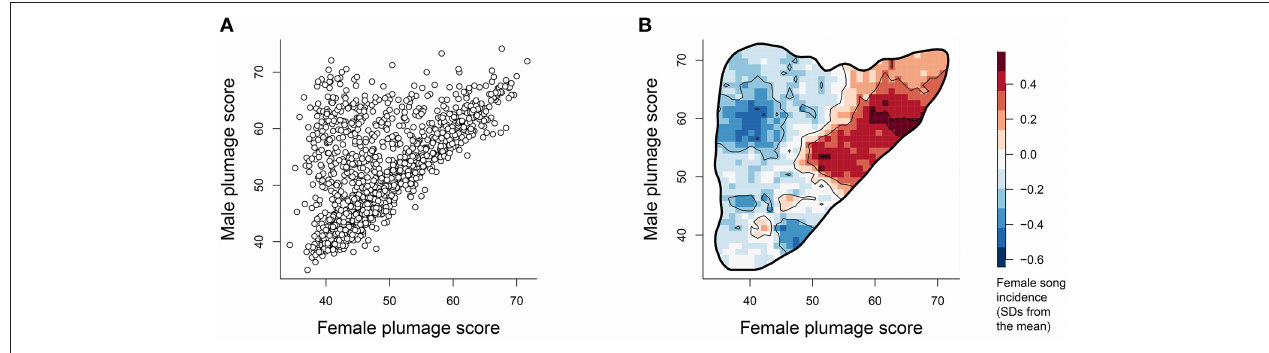
FIGURE 1 | (A) Male plumage score vs. female plumage score for each species ( N = 1023 ). (B) Contour map depicting the average of the (scaled) female song values overlaid within the 99.8% volume contour of the male vs. female plumage score distribution. Values within the plot were calculated by superimposing a 50 × 50 grid over the scatter occurring between 30 and 80 and then calculating at each grid point the mean female song scores of the closest 3% of species. The units represent standard deviations away from the mean incidence of song, with redder values indicating increasingly higher occurrence of female song.